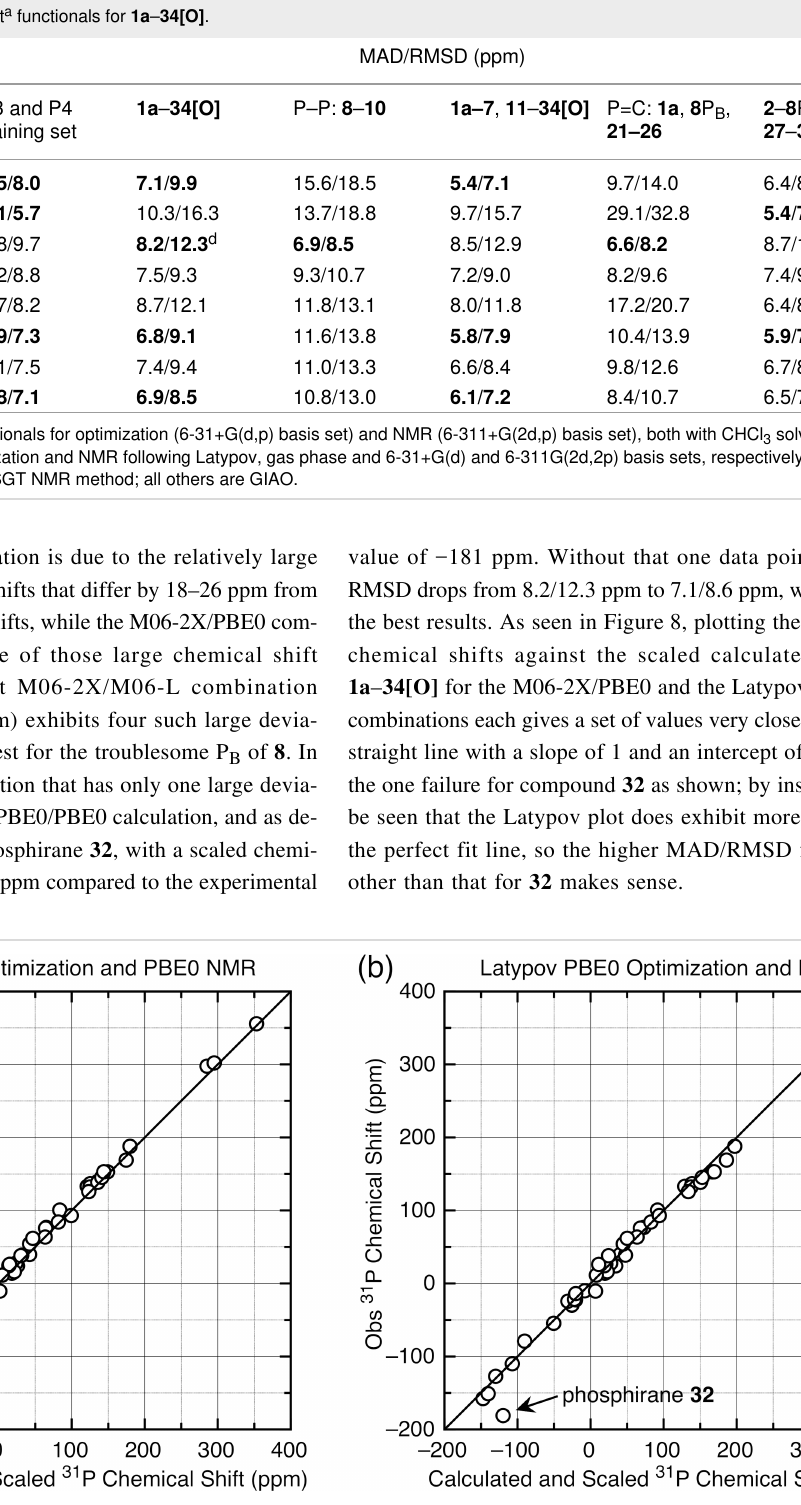
Figure 8: (a) Plot of experimental vs scaled chemical shifts derived from the tri- and tetracoordinate phosphorus training set compounds (M06-2X op- timization and PBE0 NMR (6-311+G(2d,p) basis set) referenced to H 3 PO 4 , IEF-PCM CHCl 3 solvation; see Supporting Information File 1, Table S17 for values). The line drawn (slope = 1, intercept = 0) is the perfect fit line. (b) Plot of experimental vs scaled chemical shifts derived from the Latypov training set compounds (PBE0 optimization and PBE0 NMR (6-311G(2d,2p) basis set) referenced to H 3 PO 4 , no solvation; see Supporting Information File 1, Table S9 for values). The line drawn is the perfect fit